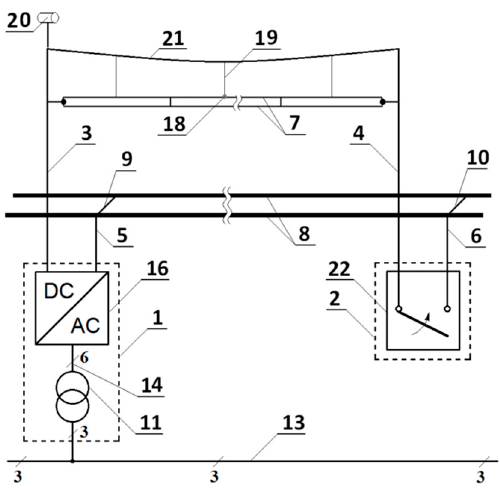
Figure 3. De-icing system scheme with one supply station.